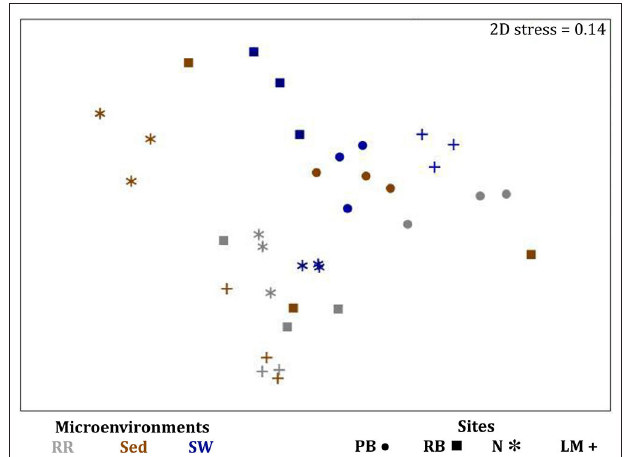
FIGURE 10 | Microenvironmental and regional partitioning of the seagrass fungal microbiome. Non-parametric multidimensional scaling (nMDS) of fungal microbiomes ( n = 35), based on a lower triangular resemblance calculated with the S17 Bray–Curtis similarity measure from relative abundances of OTUs (high values down-weighted with square root). Samples are colored by microenvironment (RR, roots and rhizomes; Sed, sediment, SW, seawater), with different shapes for sites (PB, Palm Beach; RB, Rose Bay; N, Narrabeen Lagoon; LM, Lake Macquarie). Sample clustering patterns by microenvironment within each site represent the level of similarity between samples based on the degree to which OTUs are shared between them. The 2D stress is shown in the upper right corner of the nMDS plot (Kruskal stress formula = 1, minimum stress = 0.01). The nMDS for the three microenvironments associated with the leaf is provided in Supplementary Figure 6 and a hierarchical cluster analysis (CLUSTER) is provided in Supplementary Figure 7